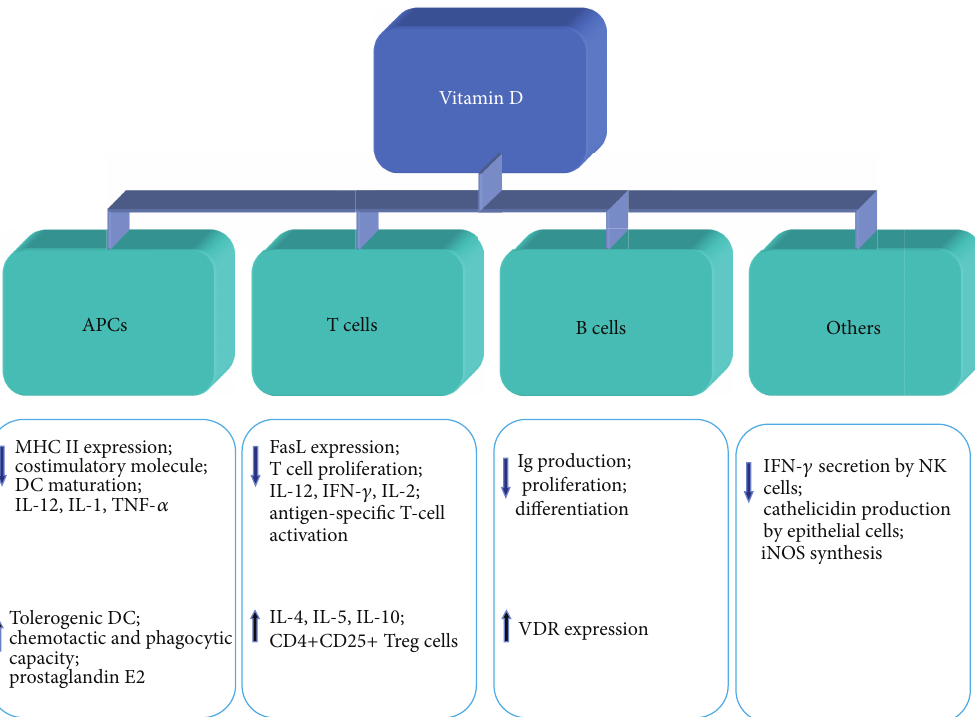
Figure 4: Effects of vitamin D on the immune system and immune responses. Vitamin D affects the immune responses including modulation of antigen-presenting cells (APCs), B, T, and NK cells. ↑ denotes induction or upregulation; ↓ denotes inhibition or downregulation. DCs: dendriticcells; iNOS:inducible nitricoxidesynthase;IL:interleukin; IFN- 𝛾 :interferon gamma; Ig:immunoglobulin; M 𝜑 :macrophage; MHC: